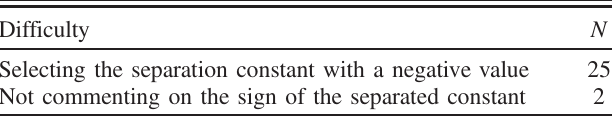
TABLE VI. Difficulties in step C2: determining the separation